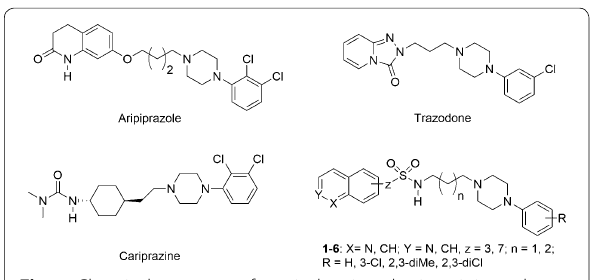
Fig. 1 Chemical structures of atypical antipsychotics aripiprazole, trazodone, cariprazine and compounds used in this study